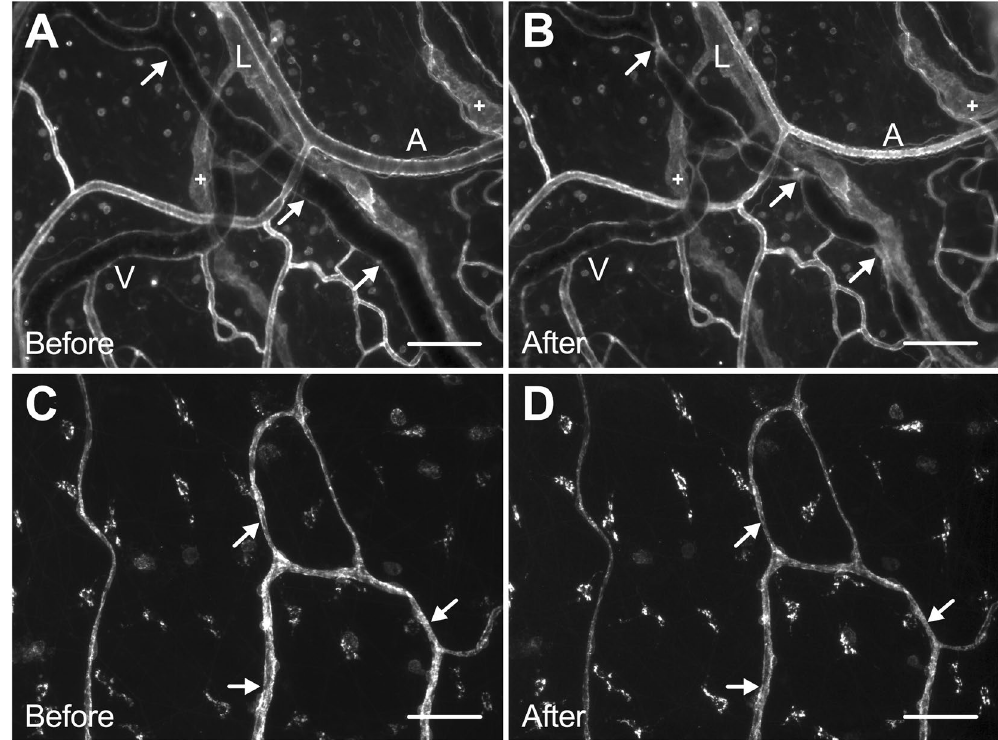
Figure 8. Qualitative evaluation of vasoconstriction responses from venules, initial lymphatics, and capillaries in Day 0 ex vivo tissues. ( A , B ) Comparison of before and after images demonstrates venule vasoconstriction response to 20 nM ET-1 and a lack of constriction from initial lymphatics, indicated by the plus signs. Similar responses were observed with 50 mM KCl exposure (data not shown). Microvascular networks were visualized with BSI-lectin labeling. Arrows indicate points of constriction. Scale bars = 100 μ m. A = arteriole, V = venule, L = lymphatic. ( C , D ) Capillary vasoconstriction responses to 50 mM KCl was observed. Microvascular networks were visualized with BSI-lectin labeling. Arrows indicate points of constriction. Scale bars = 50 μ